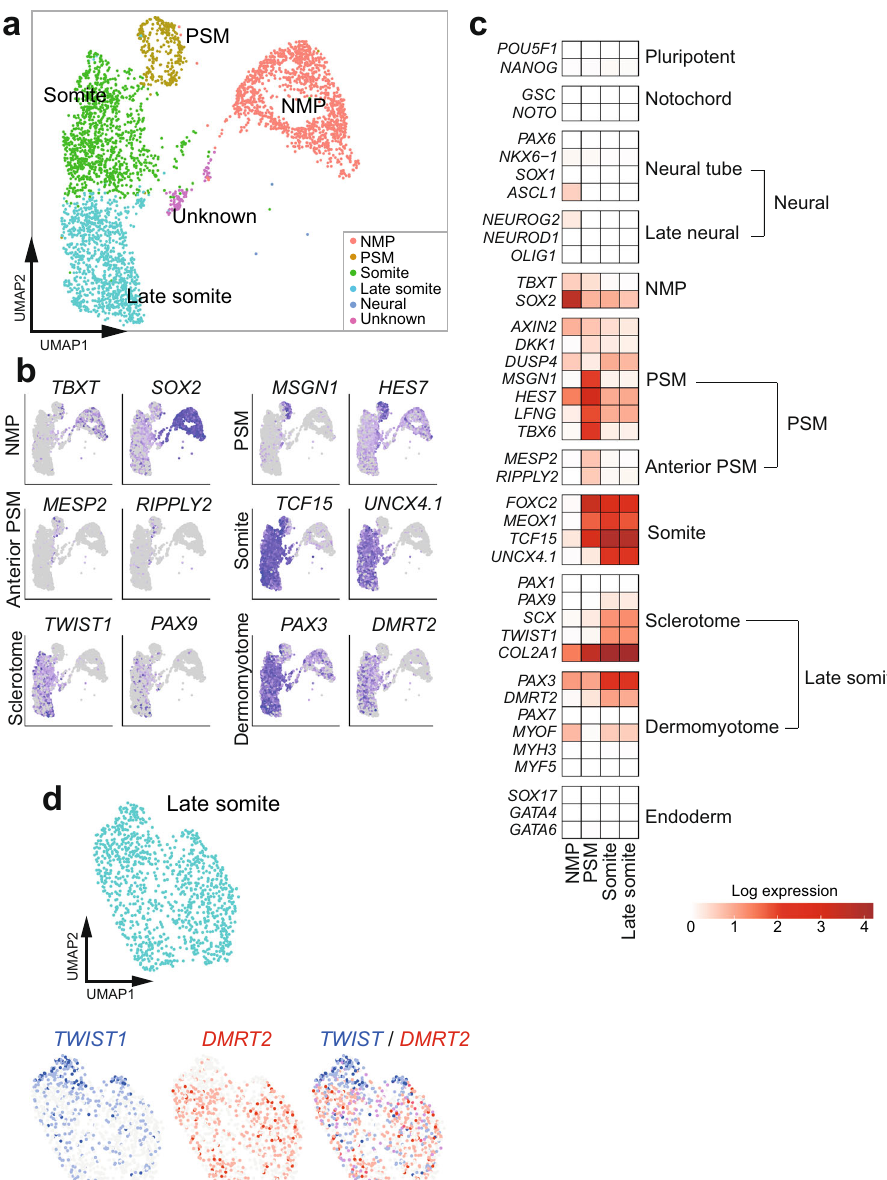
Fig. 2 scRNA-seq analyses of somitoids. a Uniform manifold approximation and projection (UMAP) plot of day 7 somitoids with 10% Matrigel ( N = 27 pooled samples, 3781 cells) colored by the 6 clusters identi fi ed in Supplementary Fig. 8a. NMP: Neuromesodermal progenitor, PSM: presomitic mesoderm. The cluster label for Neural is not shown as the cells in this cluster represent less than 0.1% of the total. b UMAP plots colored by the expression of selected marker genes. c Heatmap of the natural log expression of selected marker genes associated with early embryonic development. d Subset analysis of Late somite cells colored by the expression of sclerotome ( TWIST1 ) and dermomyotome ( DMRT2 ) markers